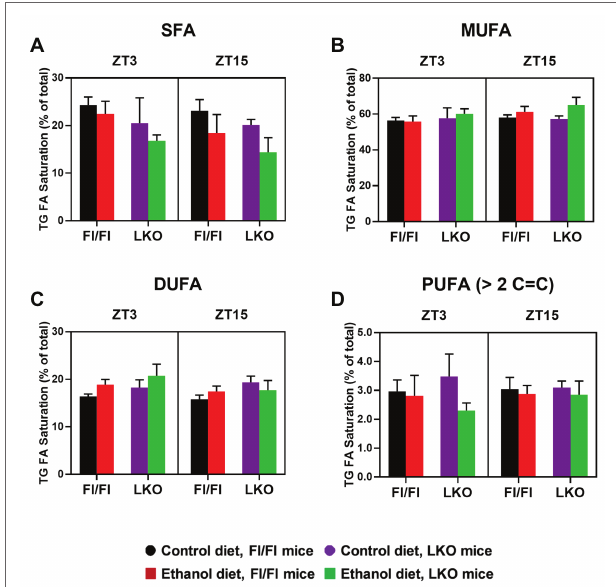
FIGURE 9 | Chronic alcohol and liver clock disruption differentially alter triglyceride fatty acid saturation in the liver. Triglyceride (TG) fatty acid (FA) saturation as a percentage of total saturated fatty acids (SFA, A ), monounsaturated fatty acids (MUFA, B ), diunsaturated fatty acids (DUFA, C ), and polyunsaturated fatty acids (PUFA, D ) was determined in liver lipid extracts from control-fed (black) and alcohol-fed (red) Bmal1 Flox/Flox (Fl/Fl) and control-fed (purple) and alcohol-fed (green) Bmal1 liver-specific knockout (LKO) mice at ZT 3 and ZT 15 (ZT = 0: lights on/inactive active, ZT = 12: lights offs/active period) using MS/MS ALL . Data are mean ± SEM for n = 3–4 mice/ genotype/diet/time-point. Results for ANOVA analyses are provided in Supplementary Table 9